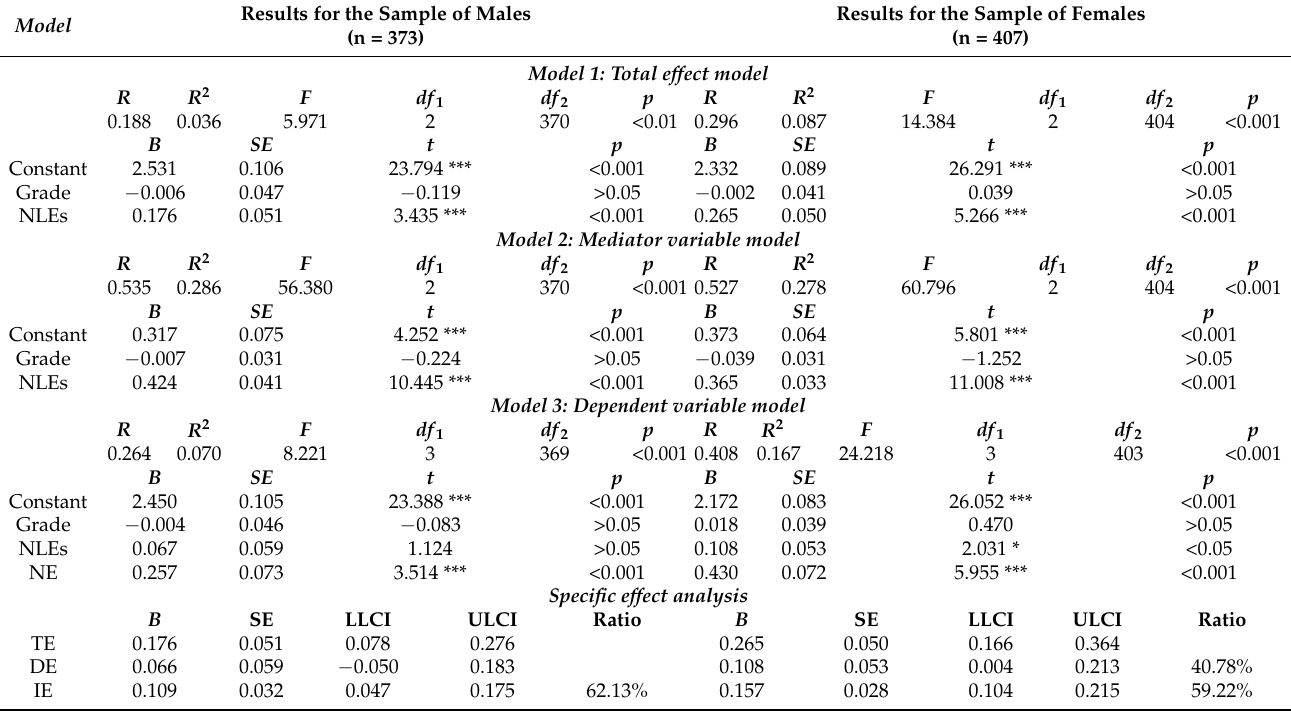
Table 2. Regression results for the mediation